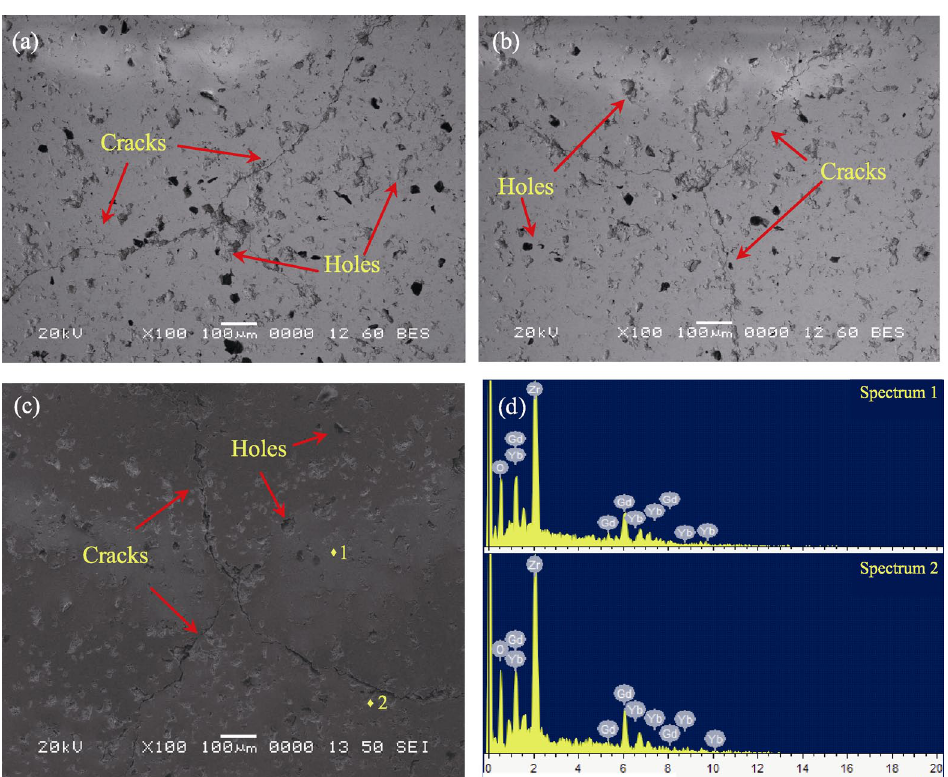
Fig. 5 SEM micrographs of the polished surface of as-sprayed freestanding GYbZ coating: (a) 1# specimen, (b) 2# specimen, and (c) 3# specimen. (d) EDS spectra of the GYbZ coating components.